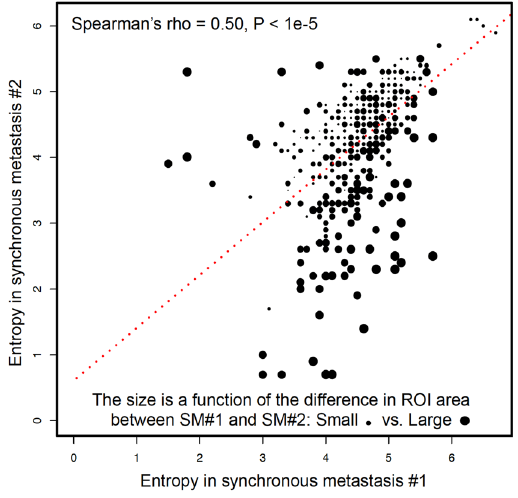
Figure 2. Comparing Entropy in paired synchronous metastases. Entropy is correlated between paired synchronous metastases across all SSFs (SM#1 vs. SM#2). We observed that larger differences in entropy were explained by larger differences in ROI area.